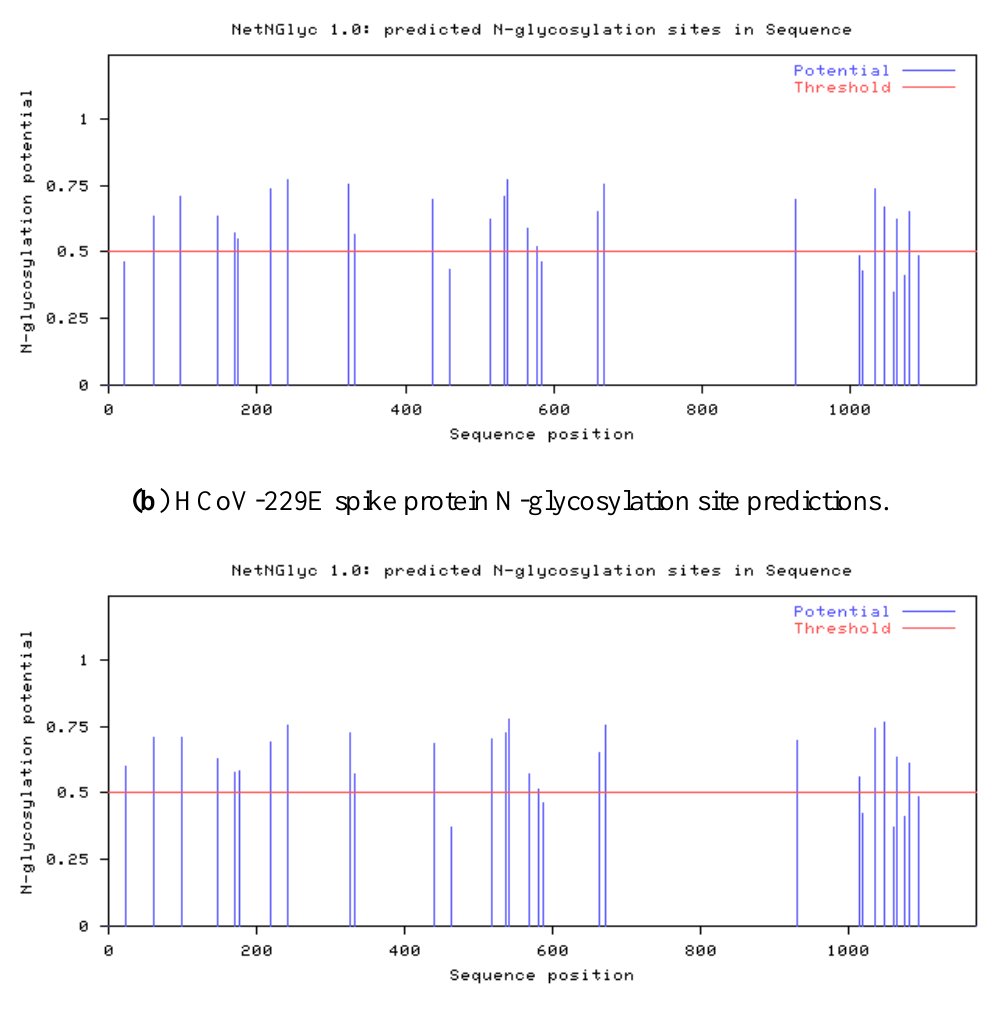
Figure 3. N-glycosylation predictions for the spike proteins of ( a ) the ACoV and ( b ) HCoV-229E. Predictions were done using the NetNGlyc 1.0 server available online [22]. (a ) ACoV spike protein N-glycosylation site predictions.